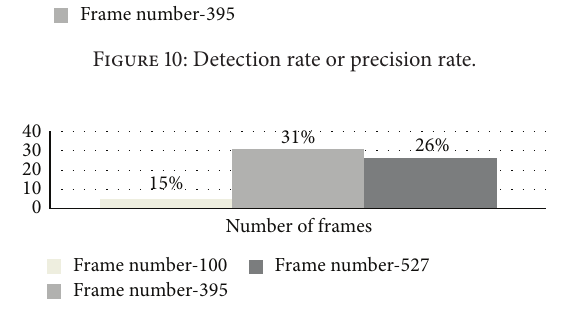
Figure 11: False alarm rate or recall rate.